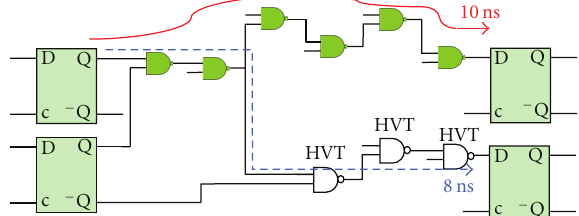
Figure 3: Replacement of LVT cells by HVT cells in noncritical